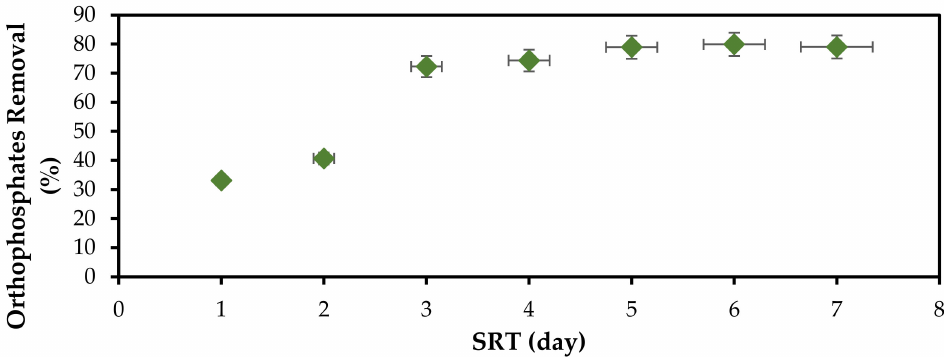
Figure 3. Orthophosphate removal with SRT variation.